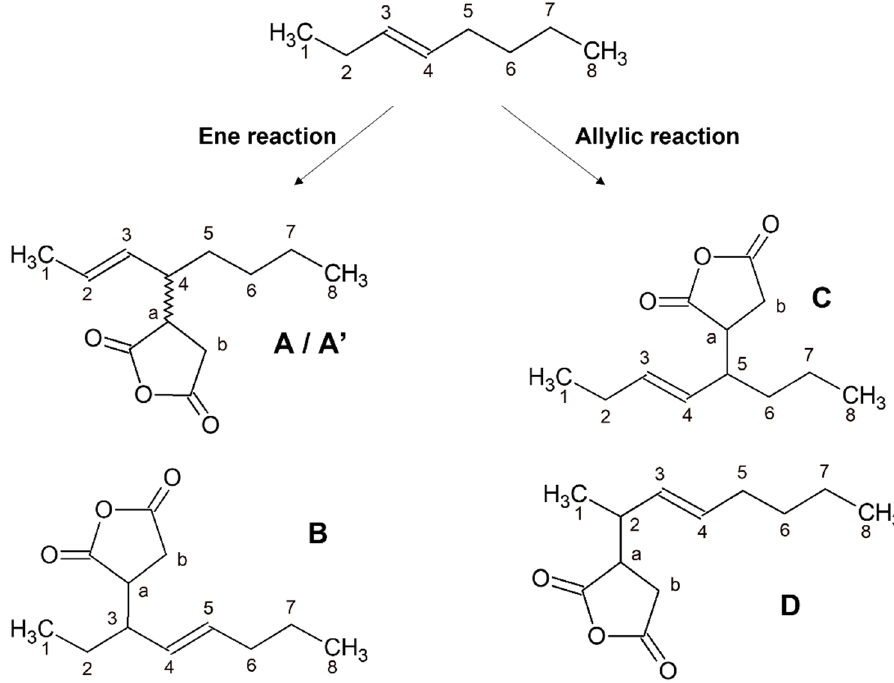
Scheme 4. Products of the ene and allylic reactions on trans-3-octene.